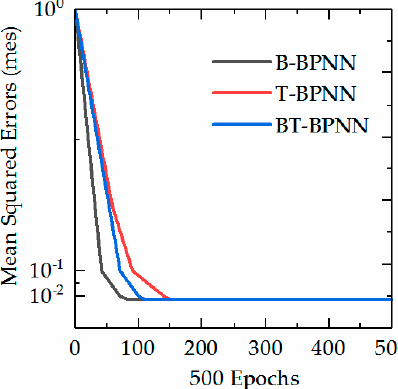
Table 7. Prediction accuracy of SVM model in the training and testing.